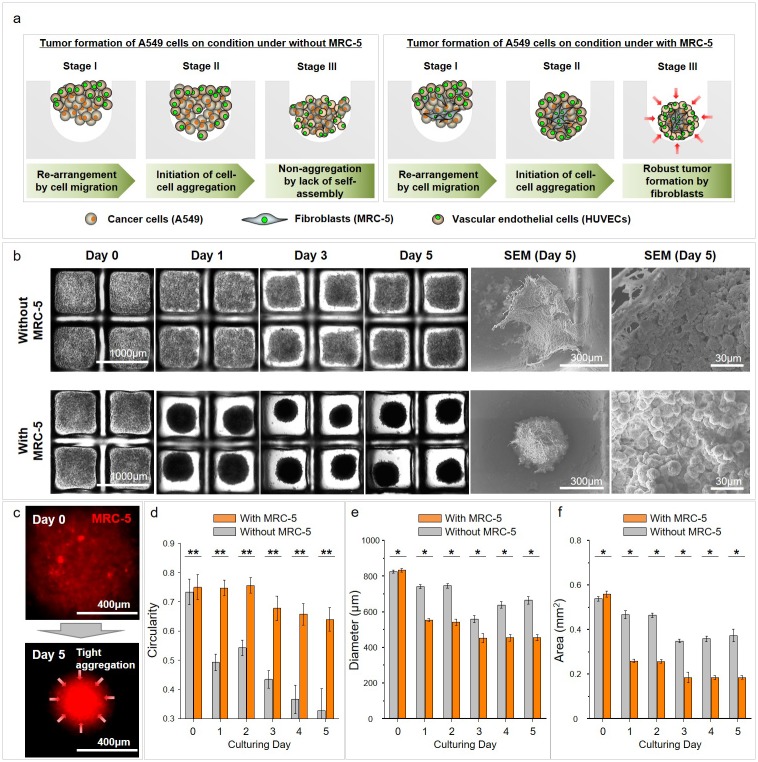
Process and morphological change for robust MCTs formation of cancer cells by fibroblasts on CLF concave microwell array.(a) MCT formation processes without and with the MRC–5 groups on the CLF concave microwell array. (b) Tumoroid formation during cultivation on the CLF concave microwell array, and SEM image used for the identification of cell-to-cell interactions. (c) MRC–5 cell localization using a cell tracker in the cell mixture during tumoroids formation. The circularity (d), diameter (e) and area (f) of MCTs on culturing days. p < 0.05(*) and p < 0.005(**).